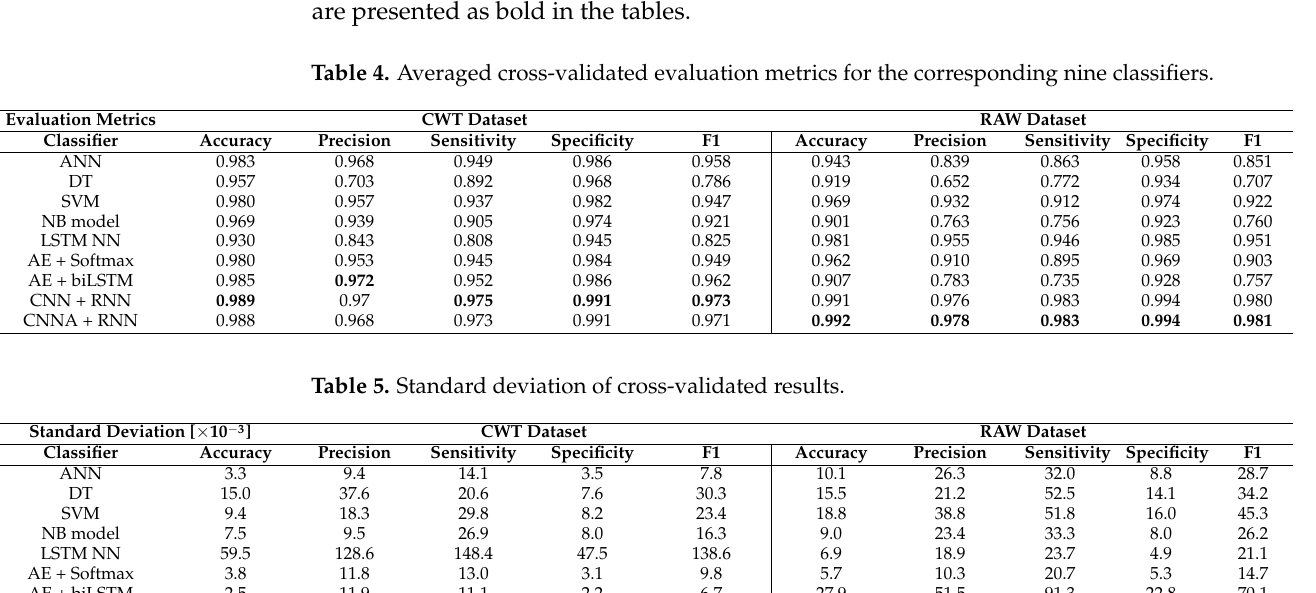
Table 6. Execution time of the classification algorithms.